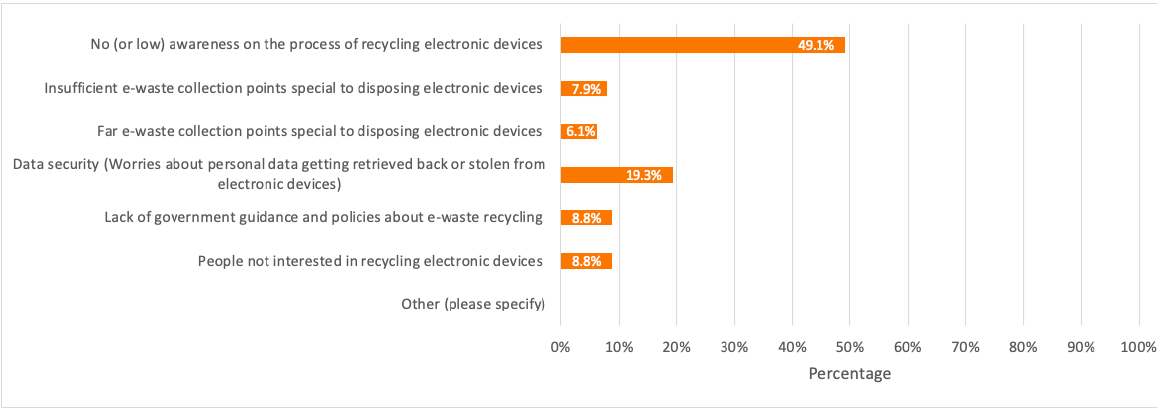
Figure 7. Respondents ’ opinion about consumers ’ main reason for low or no participation in e-waste recycling.